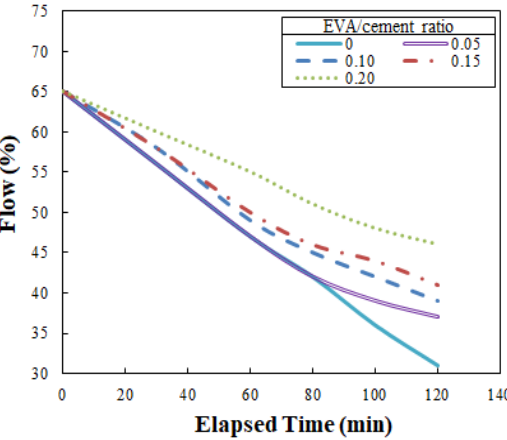
Figure 5. Change of the flow with elapsed